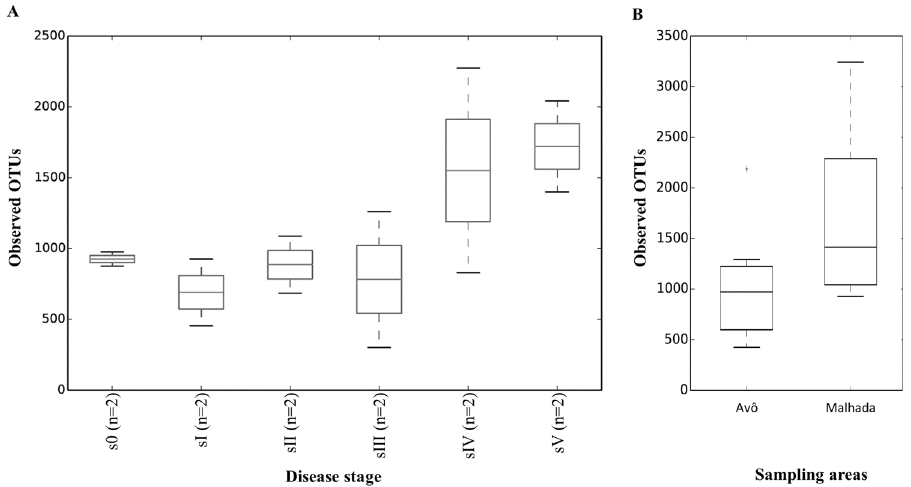
Figure 2. α -Diversity analysis of endophytic, wood colonizing bacterial communities from pine trees of six different symptomatic classes from the two sampling areas based on sequencing of PCR amplified 16S rRNA gene fragments (Chao1). ( A ) Comparison of different symptomatic stages ( B ) Comparison of